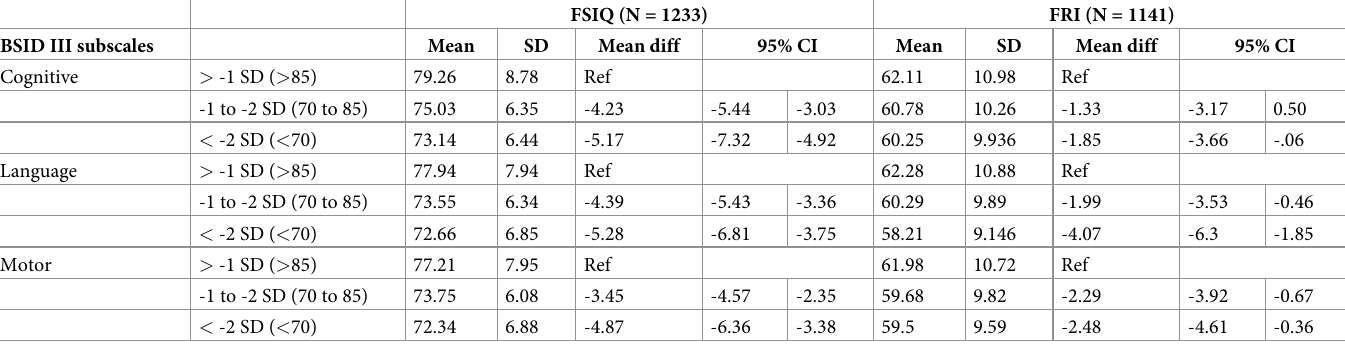
Table 6. Mean (SD) of the FSIQ at 4 years and FRI at 8 years by BSID III composite score at 2 years and the mean difference in the cohort. FSIQ (N = 1233) FRI (N = 1141) BSID III subscales